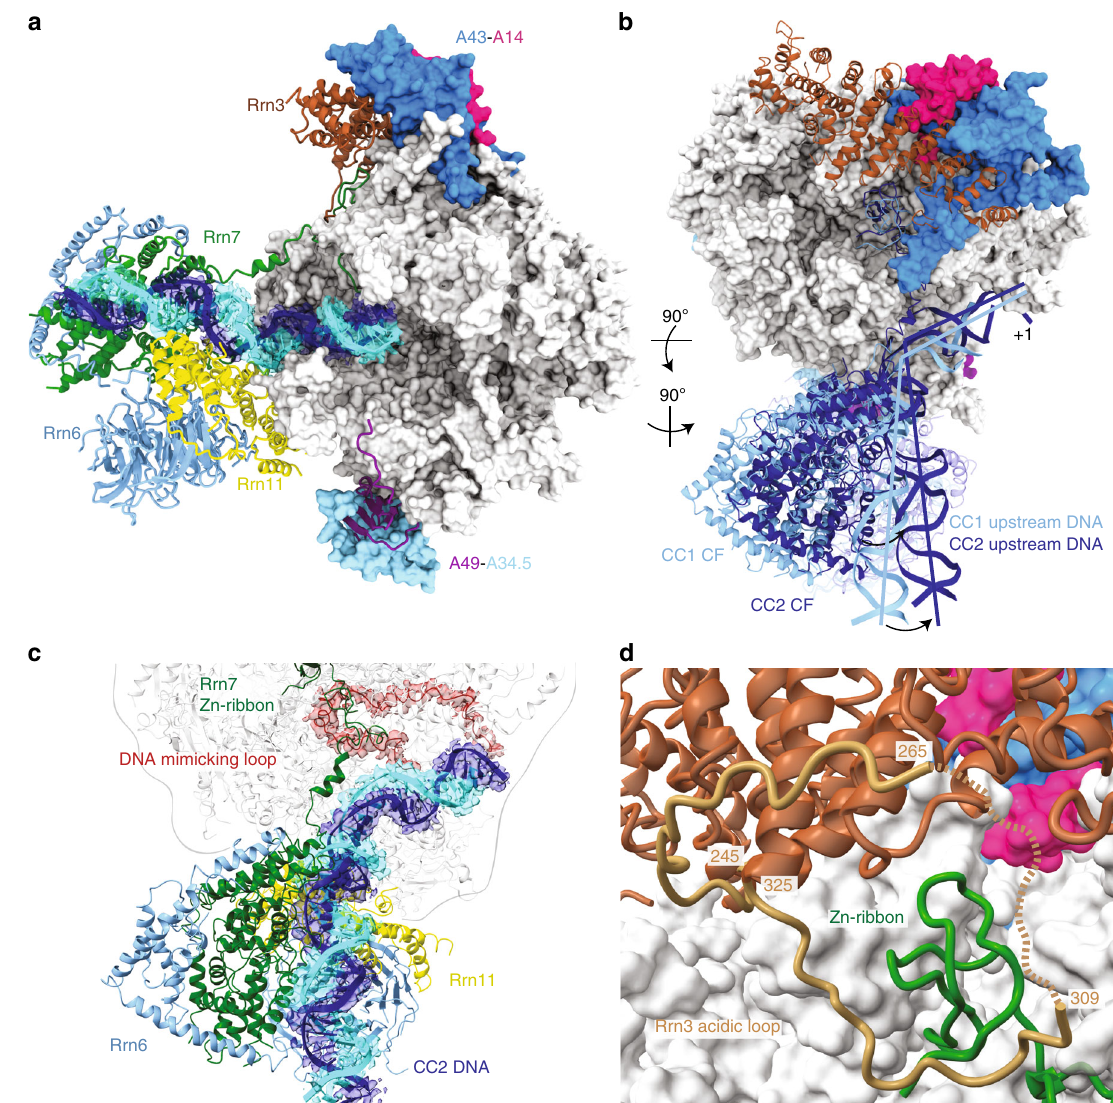
Fig. 1 Structure of the Pol I CC. a The structure of the Pol I CC2 is depicted with Pol I in light grey and the stalk subunits, A43 and A14, in blue and violet, respectively. Rrn6, Rrn11, Rrn7, Rrn3 and Pol I A49 are shown in light blue, yellow, dark green, brown and purple ribbons, respectively. The template and non- template DNA strands and the corresponding density from the sharpened globally re fi ned maps are shown in dark blue and cyan, respectively. b Transition between the CC1 and CC2 states. The structures were superimposed onto subunit Rpb8. A line shows the direction of upstream and downstream DNA duplexes in both complexes. c The downstream DNA is kinked at bp − 11 to − 7 and excluded from the Pol I cleft by the DML/expander. Pol I CC2 is shown in ribbon representation with colours as in a . Cryo-EM density for the template and non-template DNA strands and the DNA-mimicking loop (DML) obtained from the sharpened multibody-re fi ned maps are shown in dark blue, cyan and red, respectively. d The acidic loop of Rrn3 (residues 245 – 325) of Pol I CC2 contributes to the stabilization of the Rrn7 Zn-ribbon (dark green). Rrn3 is coloured in brown and the acidic loop in dark